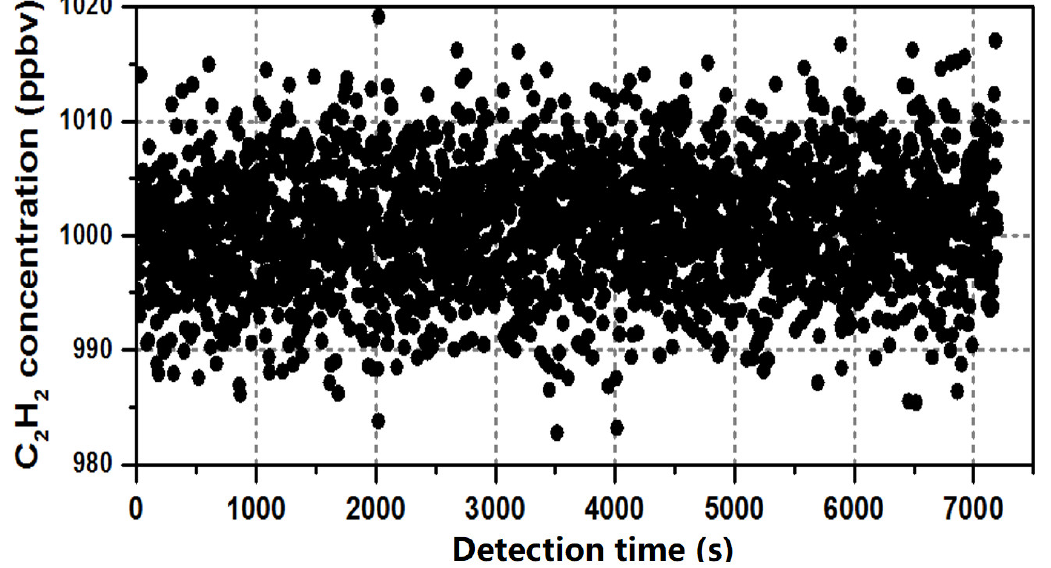
Figure 5. Detection results of 1 ppmv C 2 H 2 gas concentration in 2 h.